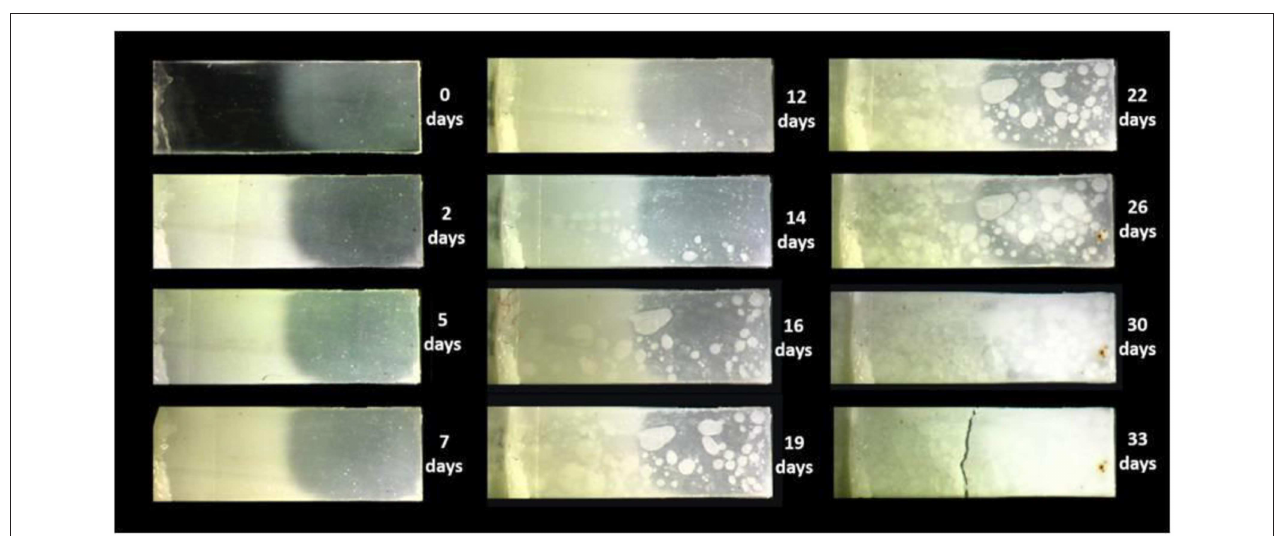
Frontiers in Materials |